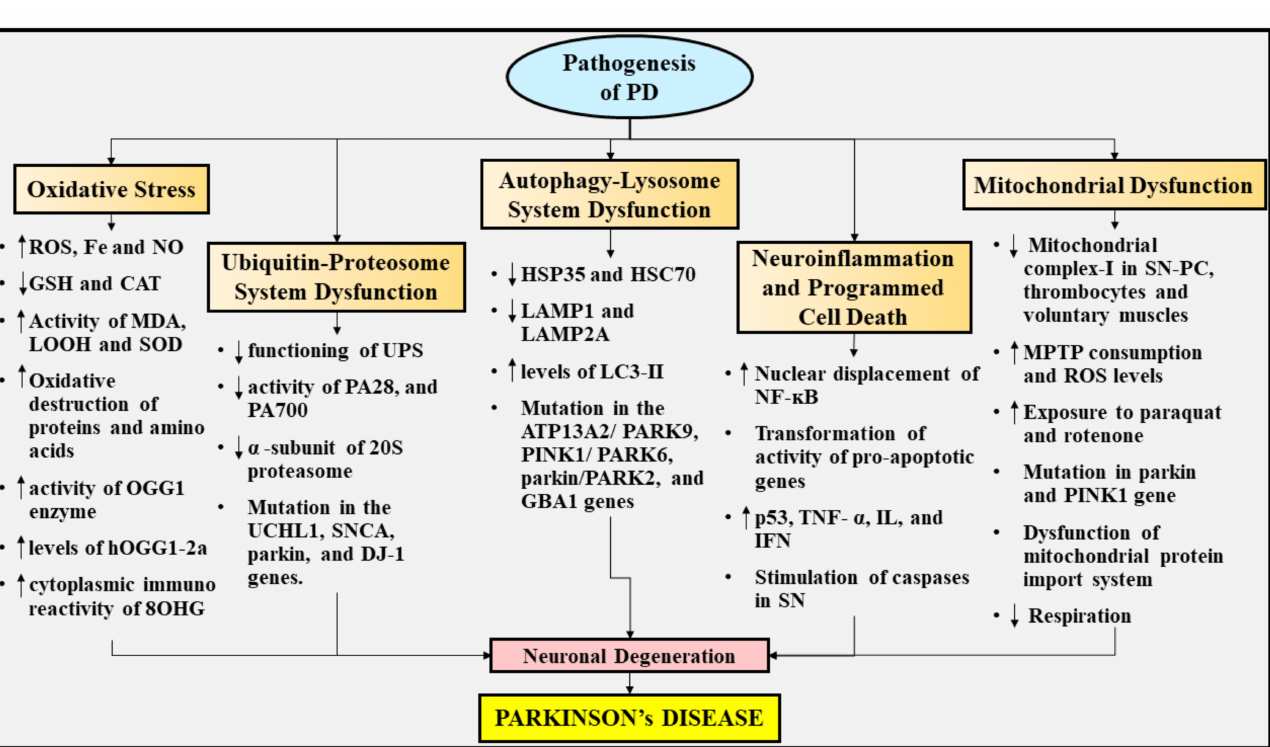
Figure 3. Pathogenesis of Parkinson’s disease. PD, Parkinson’s disease; ROS, reactive oxygen species; Fe, iron; NO, nitric oxide; GSH, glutathione; CAT, catalase; MDA, malondialdehyde; LOOH, lipid hydroperoxides; SOD, superox- ide dismutase; OGG1, 8-oxoguanine DNA glycosylase; hOGG1-2a, hOGG1 type 2a; 8OHG, 8-hydroxyguanosine; UPS, ubiquitin-proteasome system; PA28, proteasome activator 28; PA700, proteasome activator 700; UCHL1 , ubiquitin C-terminal hydrolase L1 ; SNCA , α -synuclein ; Parkin , Parkin RBR E3 ubiquitin-protein ligase ; DJ-1 , protein deglycase ; HSP35, hereditary spastic paraplegia 35; HSC70, heat shock cognate protein 70; LAMP1, lysosomal-associated membrane protein 1; LAMP2A, lysosomal-associated membrane protein 2A; LC3, microtubule-associated protein 1A/1B-light chain 3; PINK1 , PTEN- induced kinase 1 ; NF- κ B, nuclear factor kappa B; TNF- α , tumor necrosis factor- α ; IL, interleukins; IFN, interferons; SN, substantia nigra; SN-PC, substantia nigra pars compacta; MPTP, 1-methyl-4-phenyl-1,2,3,6-tetrahydropyridine; ↑ , increas- ing/activating/enhancing; ↓ ,